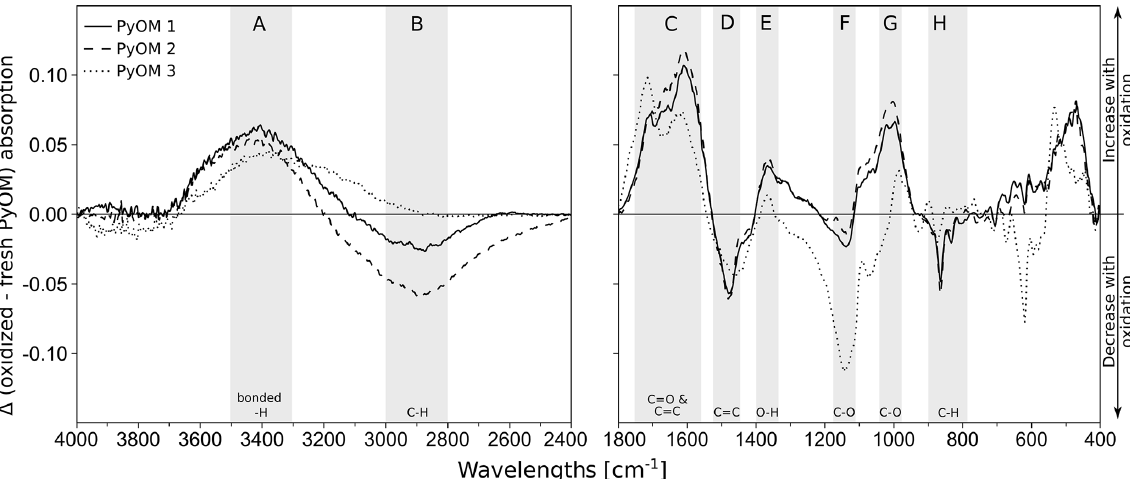
Figure 1. Difference of oxidized and fresh PyOM DRIFT spectra for PyOM 1 (loamy topsoil), PyOM 2 (loamy subsoil) and PyOM 3 (sandy soil). Areas A–H indicate the main changes after oxidation, with the corresponding absorption bands indicating increases in A = 3500– 3200cm − 1 , C − O bonds, hydroxyl groups and H 2 O; C = 1730–1680cm − 1 , aromatic carbonyl/carboxyl C=O bonds and C=C bonds (1590– 1560 and 1620–1610cm − 1 ); E = 1375cm − 1 , O − H bonds and G = 1060–1020cm − 1 , C − O bonds. Oxidation decreased the absorption at bands B = 2980–2820cm − 1 , aliphatic C − H bonds; D = 1500cm − 1 , aromatic C=C bonds; F = 1280–1200cm − 1 , C − O and H − O bonds and H = 880 and 805cm − 1 , aliphatic C − H bonds. Decreases at 1480 and 864cm − 1 can be assigned to a decarbonation with oxidation. See Fig. S1 in the Supplement for full